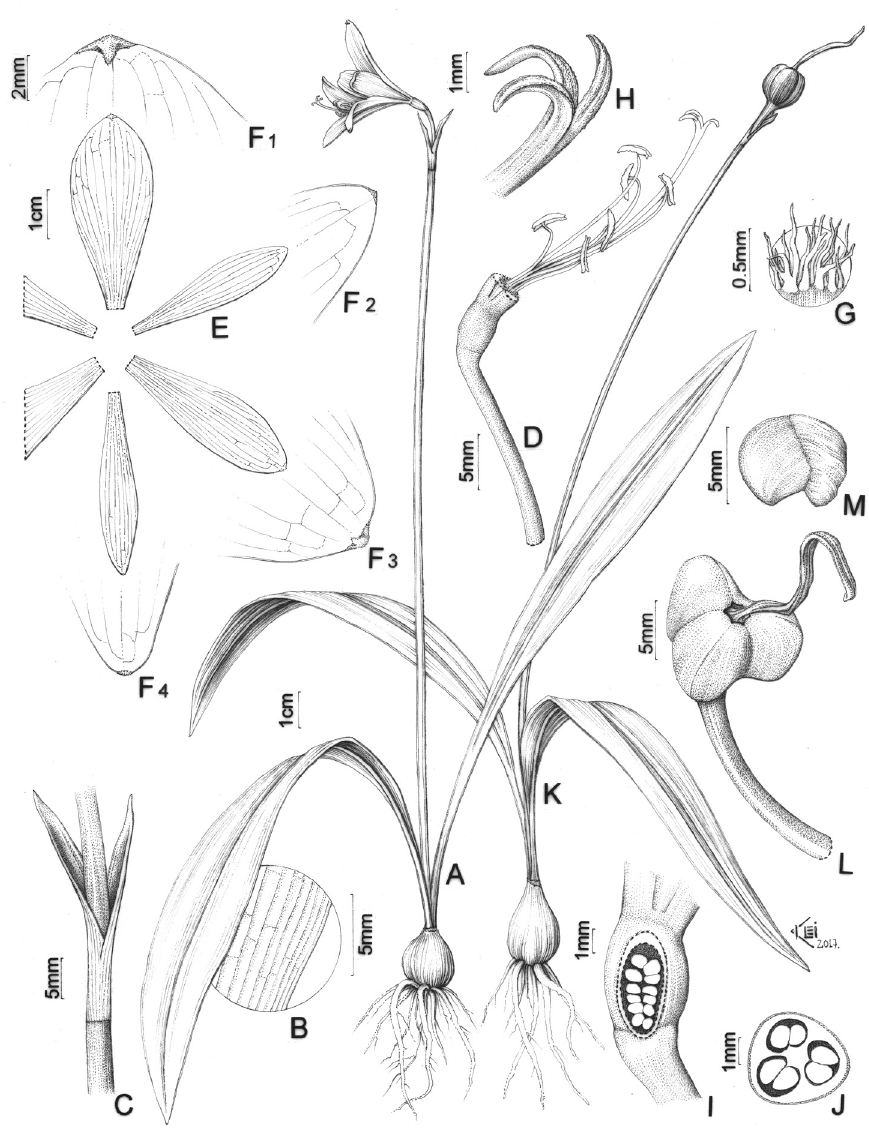
Figure 1. Eithea lagopaivae A Habit in flower B Detail of leaf venation C Spathe bracts D Flower with perigone removed, showing stamens and style E Sepals and petals F Tips of sepals and petals F1 Upper sepal F2 Lateral petal F3 Lateral sepal F4 Lower petal G Detail of fimbriae of the paraperigone H Stigma I Longitudinal section of the ovary J Cross section of the ovary K Habit in fruit L Fruit M Seed. epipetal 1.6–3.8 cm long. Anthers oblong to oblong-reniform, dorsifixed, versatile, dehiscing longitudinally, 2.5–5 mm long before anthesis; pollen pale yellow. Ovary trilocular, obtuse trigonal, obovoid, greenish, 3.5–9 mm long and 3–8 mm